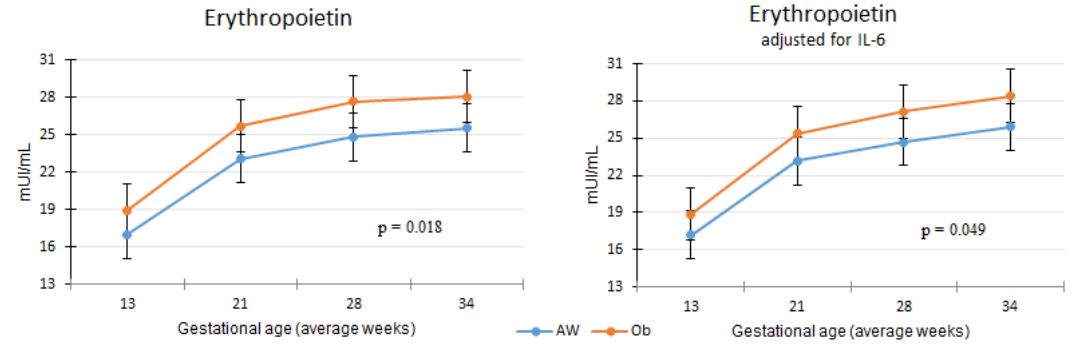
Figure 2. Erythropoietin concentration between adequate weight (AW) and obesity (Ob) groups.